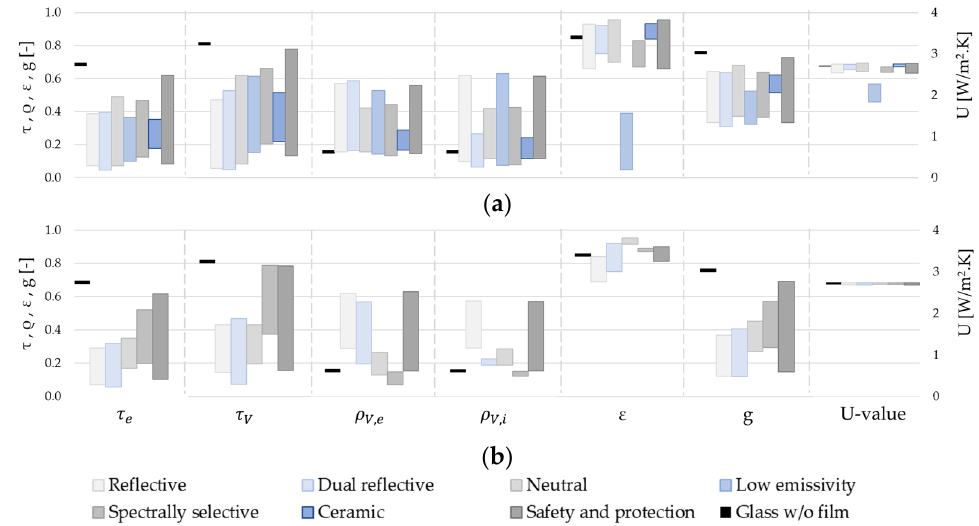
Figure 7. Ranges of values of the main thermal and solar optical properties of clear double glazing with and without different types of SCFs applied to the internal ( a ) and external ( b ) glass surfaces.